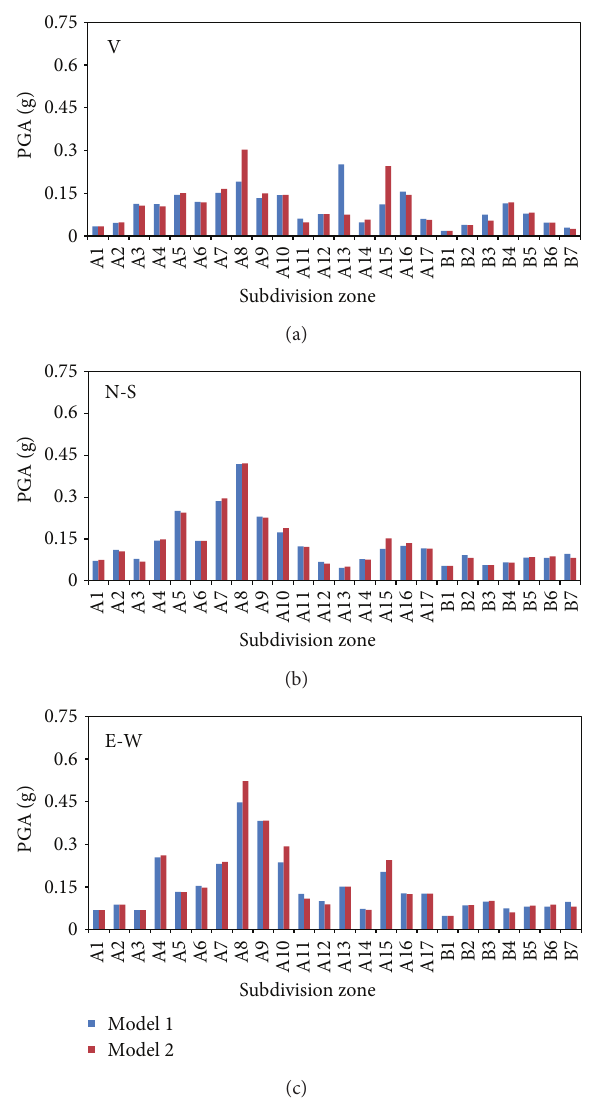
Figure 6: PGA predictions in the 24 seismic subdivision zones from two models.